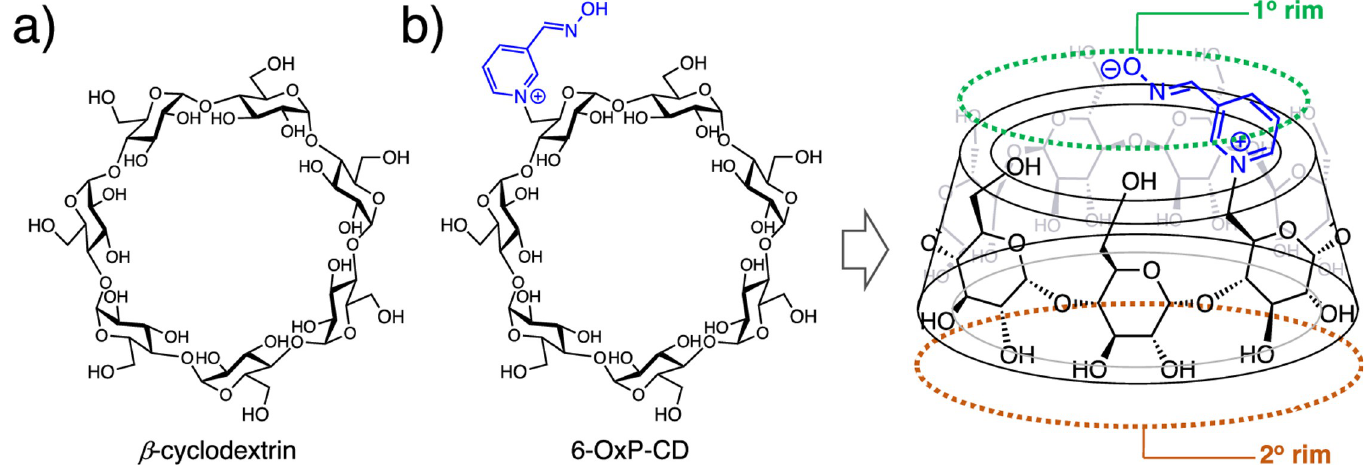
To this end, an interesting family of supramolecular scaffolds that have been heavily explored to perform this prophylactic function are the cyclodextrins [28–30]. Cyclodextrins (CDs) are cyclic oligosaccharides that are composed of glucosyl units linked in an α -1,4-fash- ion (Fig 2A) [28]. It is this arrangement of glucosyl units that gives CDs their characteristic three-dimensional structure resembling that of a frustrum or a cone that is open at both ends, one larger than the other. An interesting property of CDs is that their interior is hydrophobic in nature while their exterior is hydrophilic, therefore allowing these scaffolds to serve as hosts to a myriad of organic molecules [31–33] in an aqueous environment, including those belong- ing to the nerve agent class (Fig 2B) [34–36]. CDs have become molecules of interest due to their established use in the medicinal field coupled to the various methods available for their